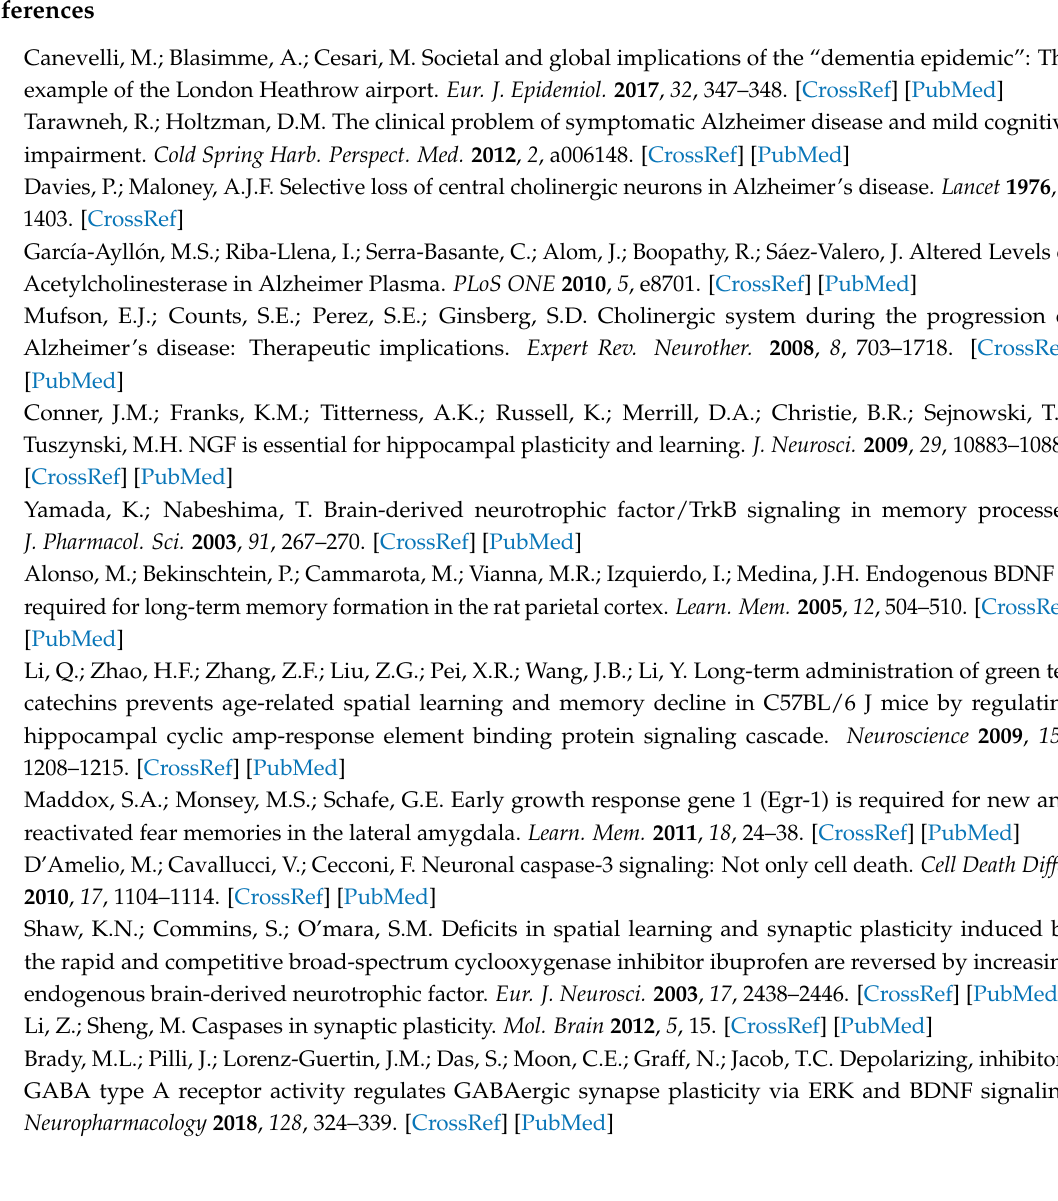
Figure S1: UHPLC-MS/MS of crude extract of Stachys Sieboldii; Table S1: Compounds present in crude extract of Stachys